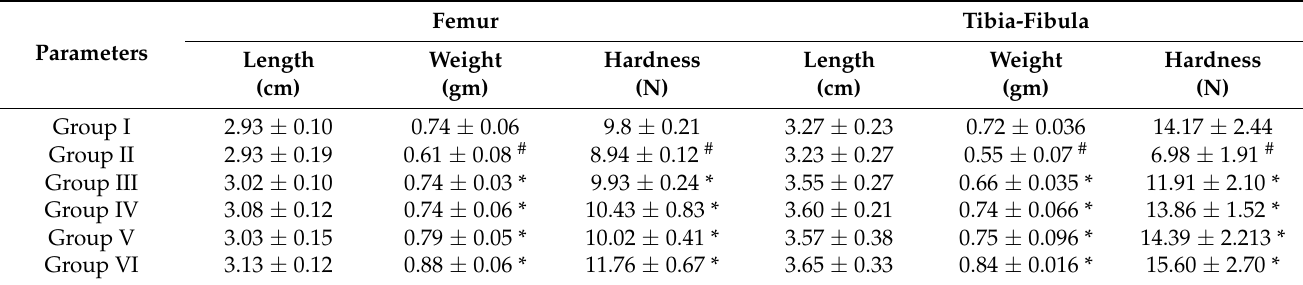
Table 4. Effect of therapeutic interventions on femur and tibia–fibula weights, lengths, and hardness.